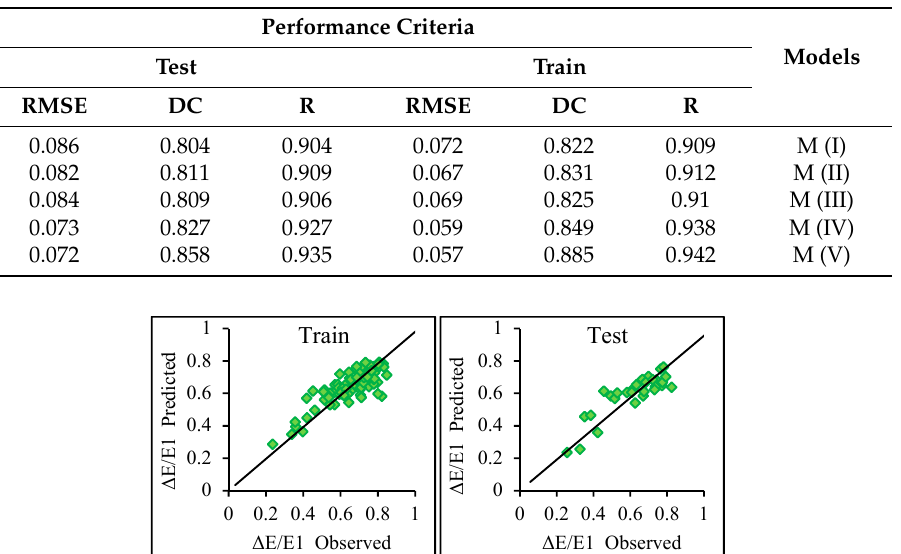
Table 4. Statistical parameters of the KELM models for the trapezoidal shape channels.